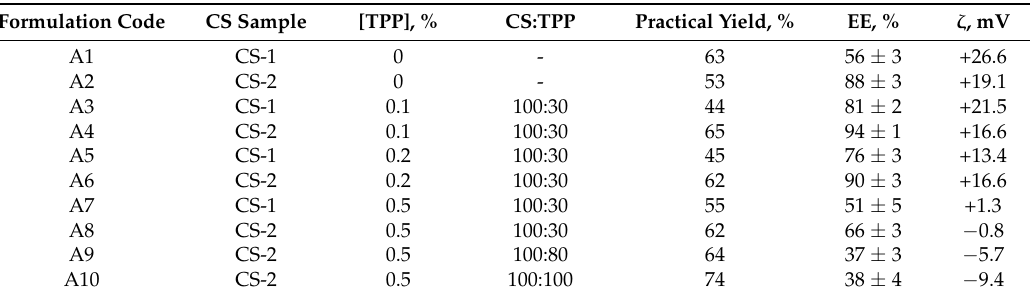
Table 2. Microcapsules formulation and main